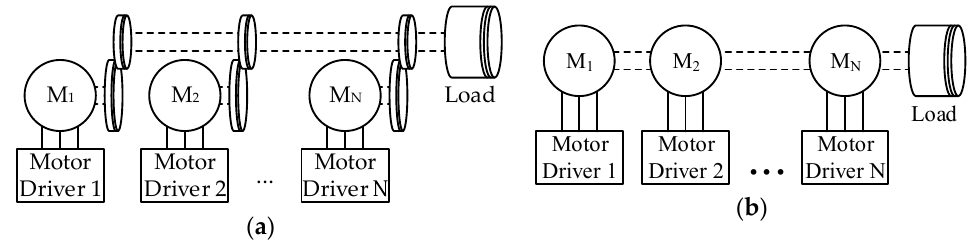
Figure 2. Configurations of multiple motor drive: ( a ) with multiple transmissions; ( b ) with single shaft.